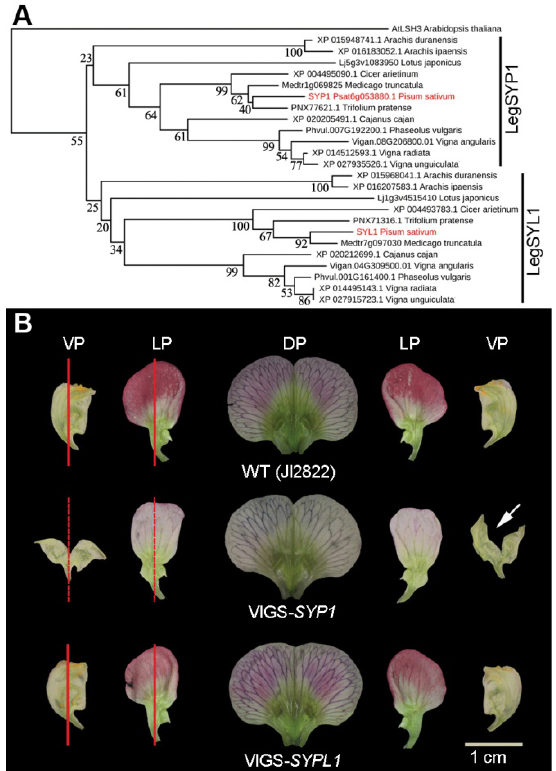
Figure 4. Phylogenetic analysis of LSH3 orthologs in legumes. ( A ) The neighbor-joining tree of AtLSH3 orthologs in legume plants. The bootstrapping value is located in each node as percentages along the branches. Red lines indicate two proteins in pea, SYP1 and SYL1. ( B ) The lateral petals and ventral petals of the wild type and VIGS- SYP1 and VIGS- SYL1 silenced plants . The red lines indicate the IN asymmetry and the dotted lines indicate the abolishment of IN asymmetry. The arrow indicates where the ventral petal was cut to flatten the petal. DP, dorsal petal; LP, lateral petal; VP, ventral petal.